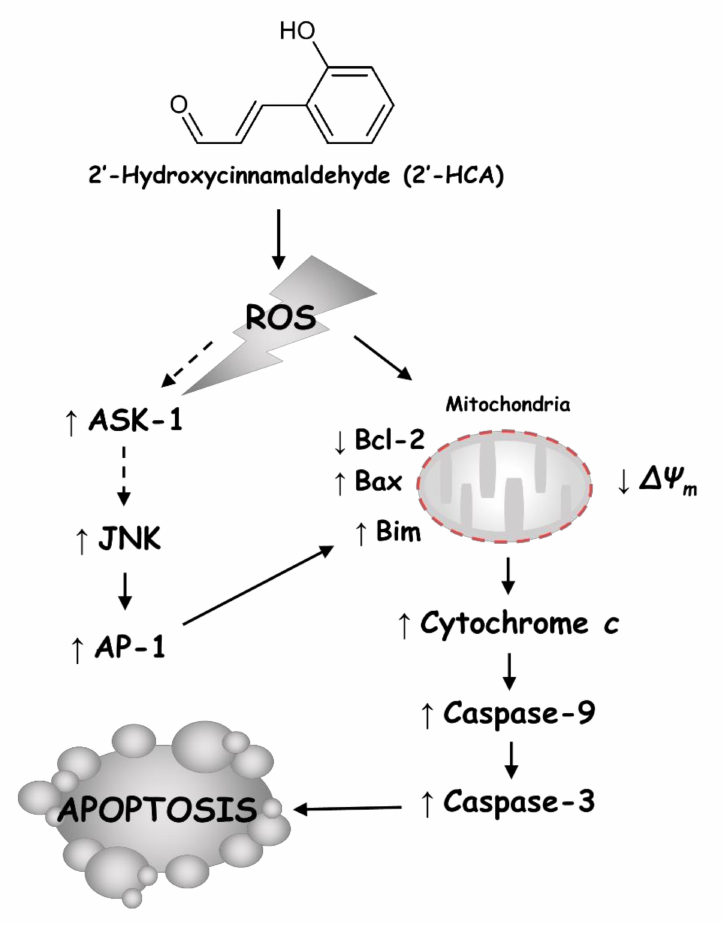
Figure 9. Graphic abstract. The molecular mechanism of 2 (cid:48) -HCA via ROS/JNK/apoptosis in human